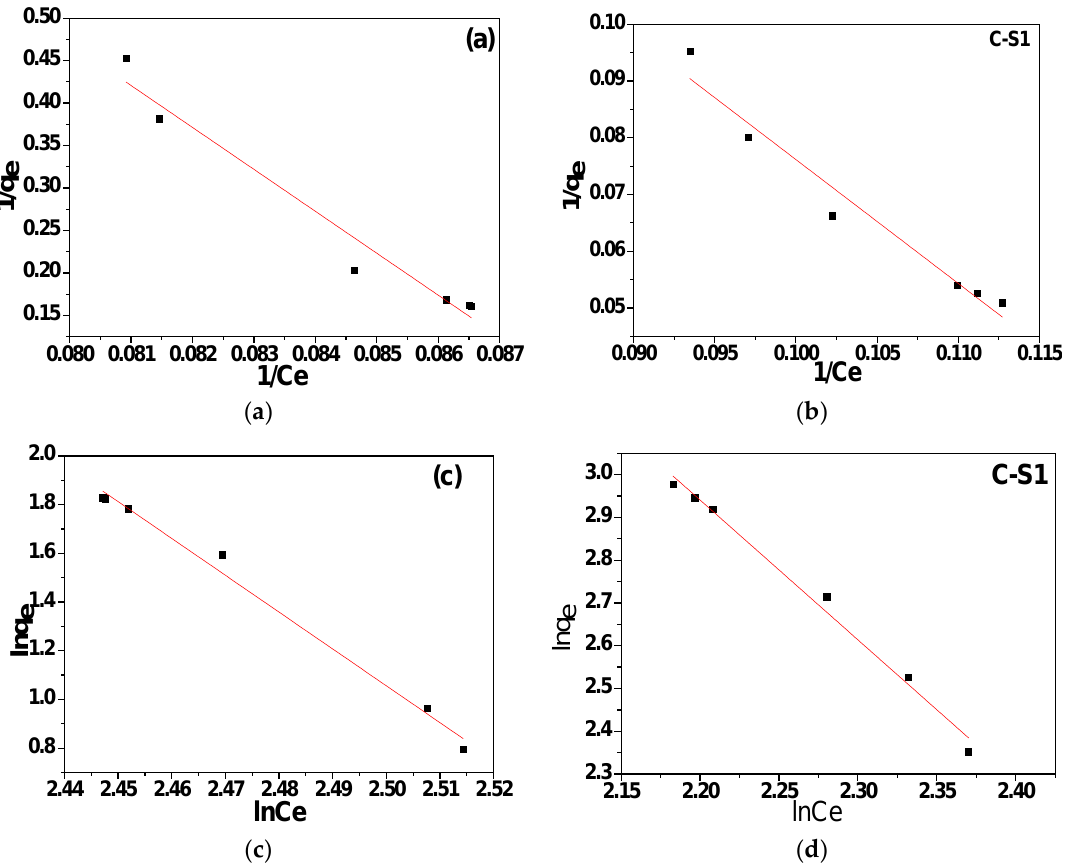
Figure 9 . ( a , b ) Langmuir adsorption isotherm and ( c , d ) Freundlich adsorption isotherm for MB adsorption of ( a , c ) C-S0 and ( b , d ) C-S1.